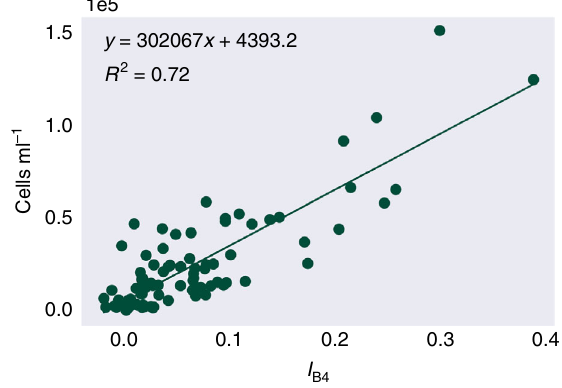
Fig. 3 Cell density versus I B4 . Linear regression of the scaled integral of Sentinel 2's Band 4 relative to Bands 3 and 5, versus concentrations of green algal cells within the snow ( n =